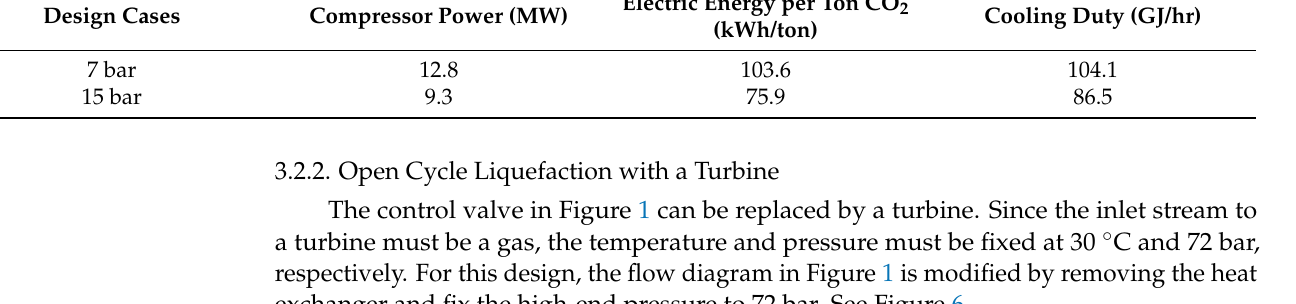
Table 4. Results of the open-cycle liquefaction design with a